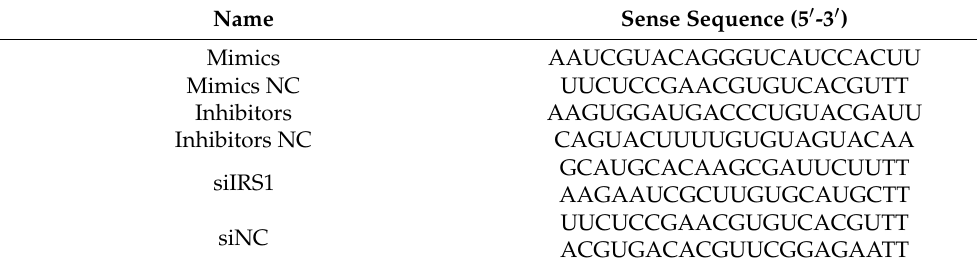
Table 2. RNA oligonucleotides in this